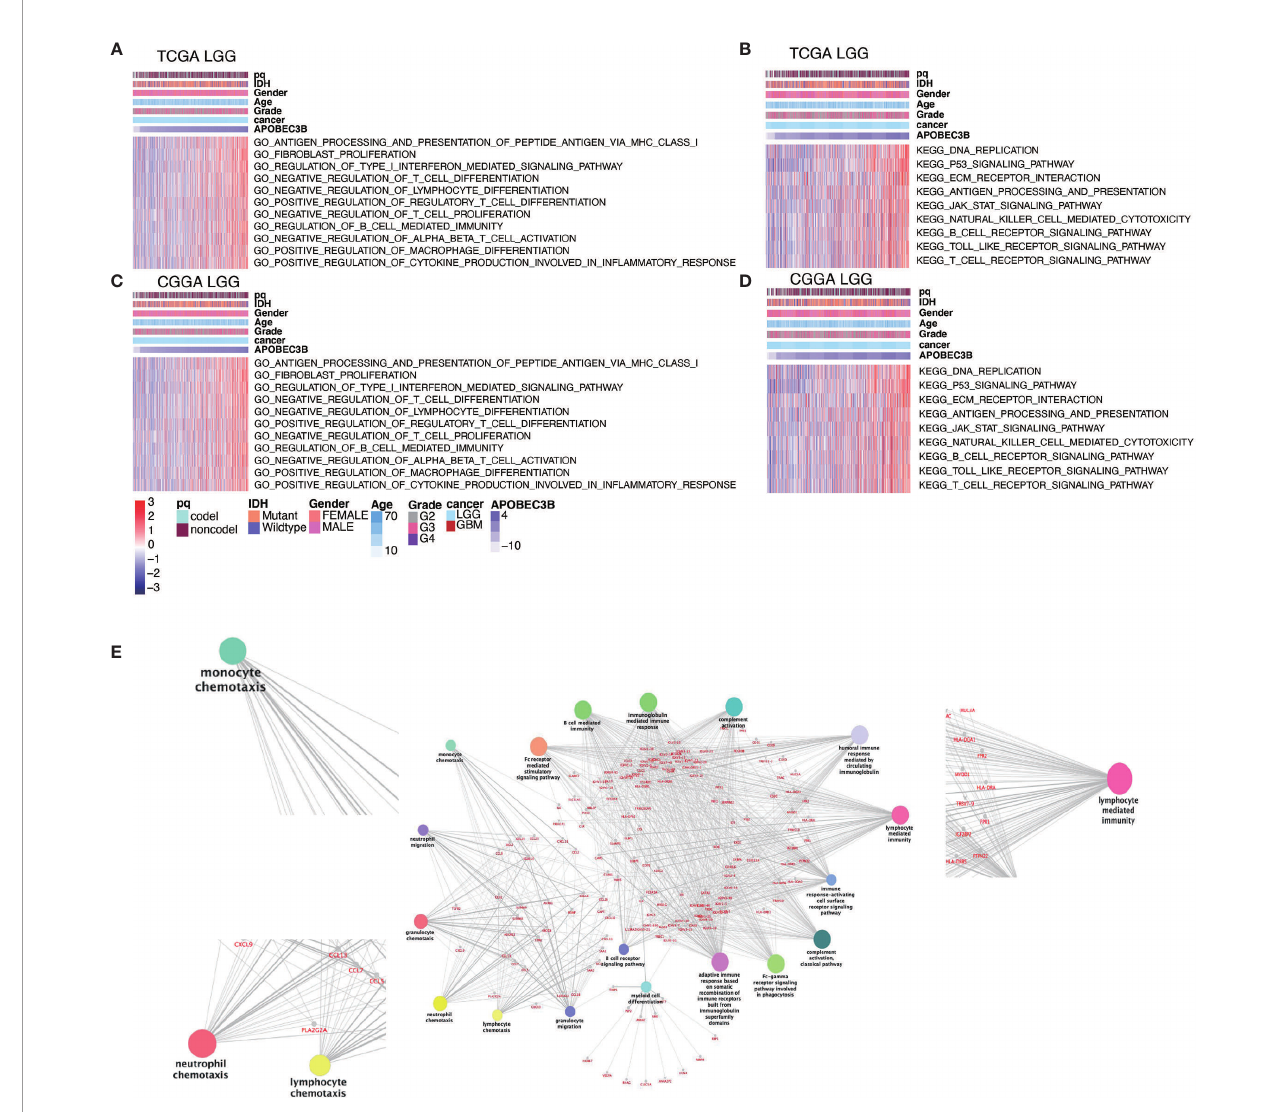
FIGURE 6 | APOBEC3B-related biological functions in LGG. GO analysis based on APOBEC3B levels in (A) TCGA and (C) CGGA datasets in LGG patients. KEGG pathway analysis based on APOBEC3B expression levels in (B) TCGA and (D) CGGA datasets in LGG patients. (E) The APOBEC3B related pathway revealed by APOBEC3B positively associated genes in TCGA datasets with